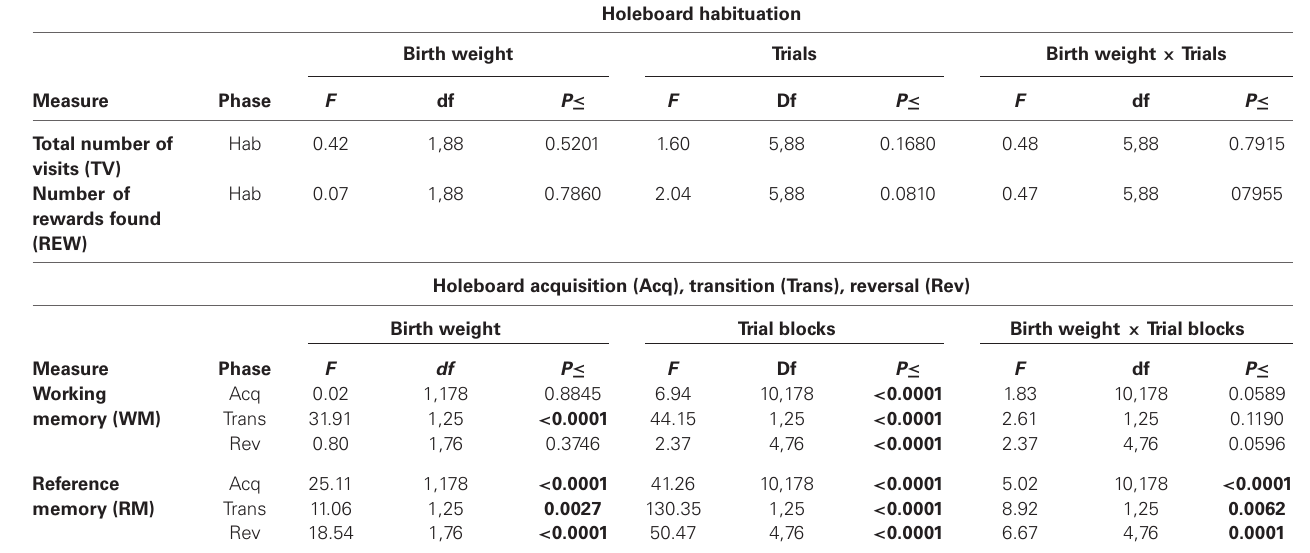
Table 1 | Performance of vLBW and NBW piglets in the spatial cognitive holeboard task during habituation (Hab), and during the acquisition (Acq), transition (Trans), and reversal (Rev) phase . Holeboard